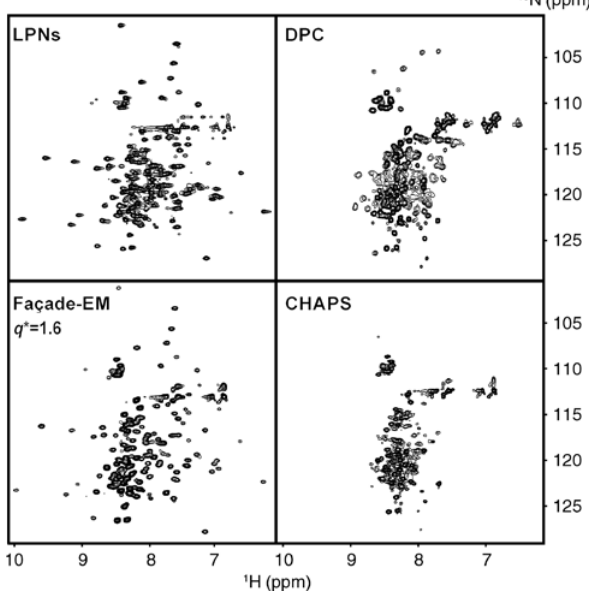
Figure 3: 1 H, 15 N-TROSY (transverse relaxation optimized spectro- scopy) spectra of p75- Δ ECD in DMPC/MSP1 LPNs [10], DMPC/Façade- EM q = 1.6 bicelles, dodecylphosphocholine (DPC) [10], and CHAPS. Spectra were acquired at pH 7.0, 30 °